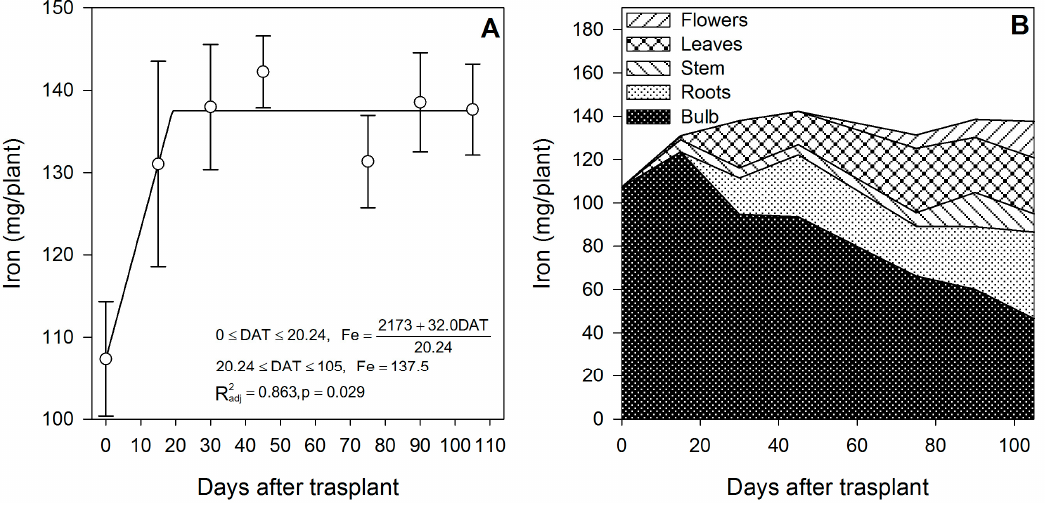
Figure 8. Iron accumulation in lilium: ( A ) Segmented analysis of iron accumulation over the growing season; ( B ) Iron distribution in the lilium plant parts. Day 0 = transplant day, days 0 to 15 = sprouting and initial vegetative growth, days 15 to 60 = rapid vegetative growth plus flower buds formation, days 60 to 105 = blooming. DAT = days after transplant.